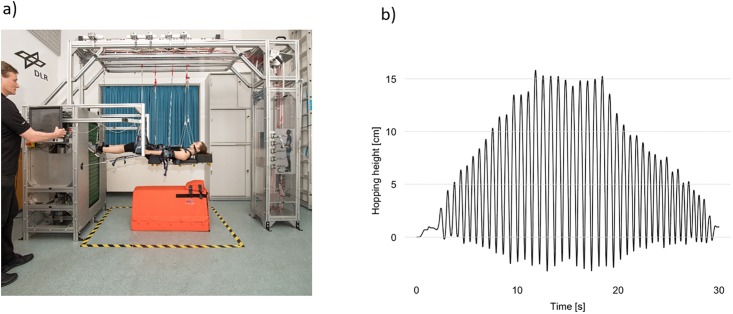
The vertical treadmill facility (VTF).Panel a shows the setup of the VTF. The elongation of pistons of one 30s hopping trial at 0.38g is shown in Panel b. The elongation of the VTF pistons was used to calculate height of flight (hopping height/jump height).